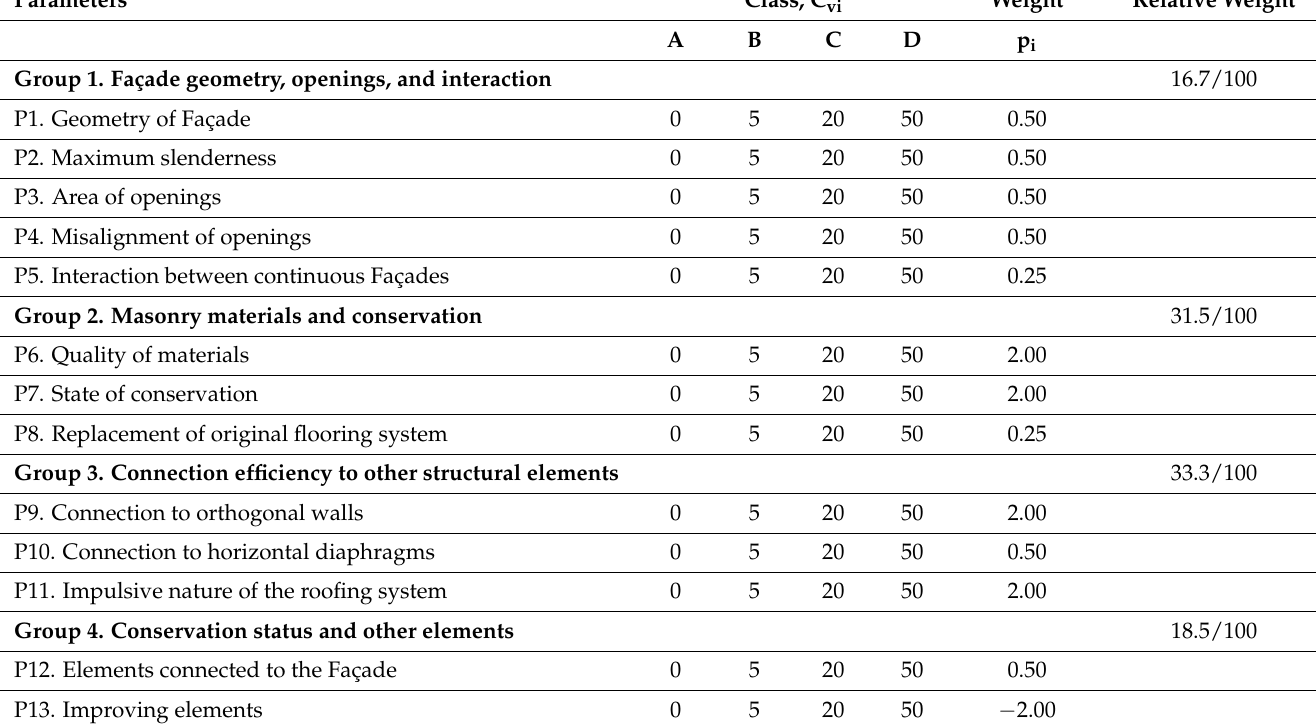
Table 5. Parameters functional to the Façade Approach,